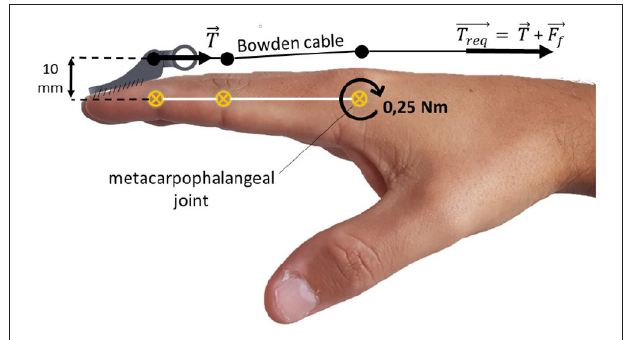
FIGURE 7 | Static scheme for cable tension estimation. T is the estimated cable tension, T req is the required cable tension, and F f is the Bowden cable friction